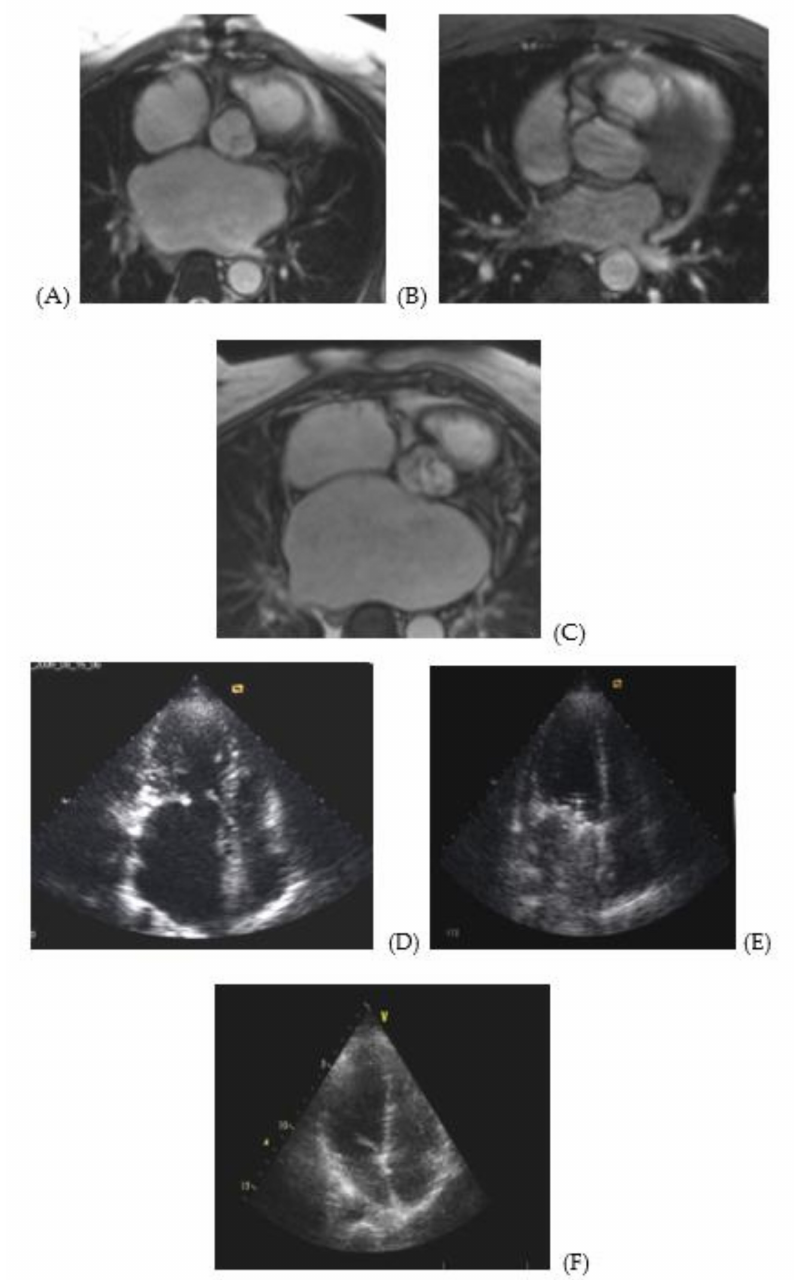
Figure 1. MRI and echocardiography images of atria of a 48 year-old male patient with MVD prior to surgery and 5 years later. MRI image of a cross section of the right and left atria at the level of the aortic root of a 48 year-old male patient with stenosis and mitral valve insu ffi ciency (3d degree): ( A ) prior to surgery, ( B ) following surgery, ( C ) normal atria of a patient from the control group. Apical access echo image of the left atrium of a 48 year-old male patient with stenosis and mitral valve insu ffi ciency (3d degree): ( D ) prior to surgery, ( E ) following surgery, ( F ) normal atria of a patient from the control